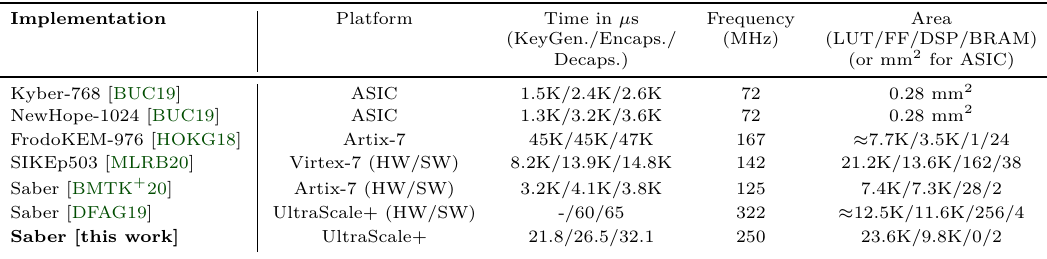
Table 5: Comparisons with existing implementations of CCA-secure KEM schemes. All results for Saber use module dimension